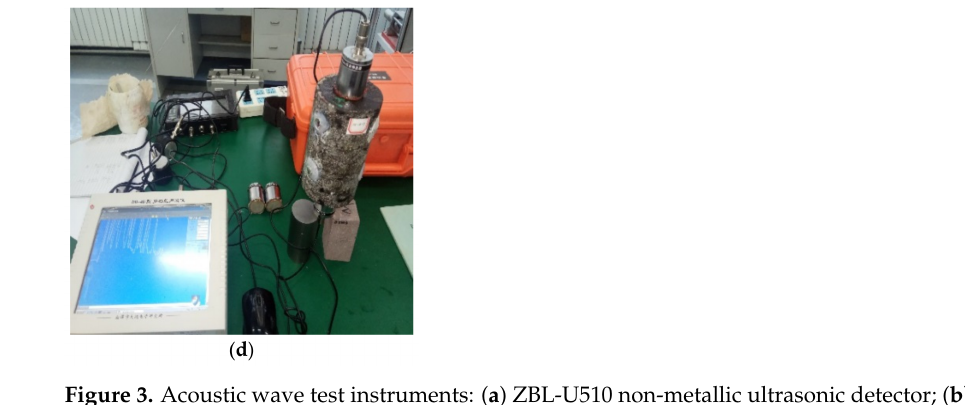
Figure 3. Acoustic wave test instruments: ( a ) ZBL-U510 non-metallic ultrasonic detector; ( b ) sample